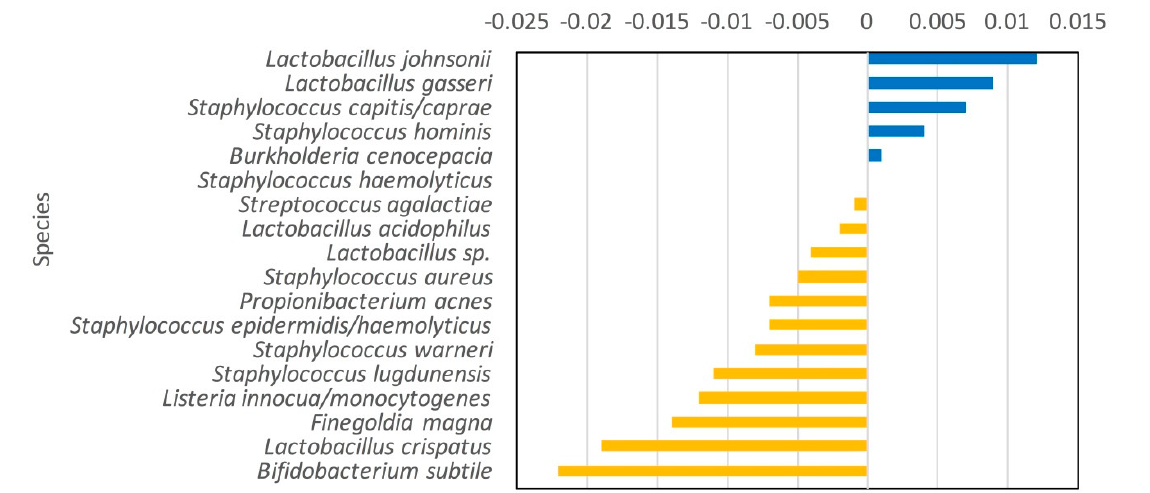
Figure 2. Differences in mean relative abundance at the species level (IC/BPS minus controls). Blue indicates more abundant among urologic chronic pelvic pain syndrome (UCPPS). Yellow is more abundant among